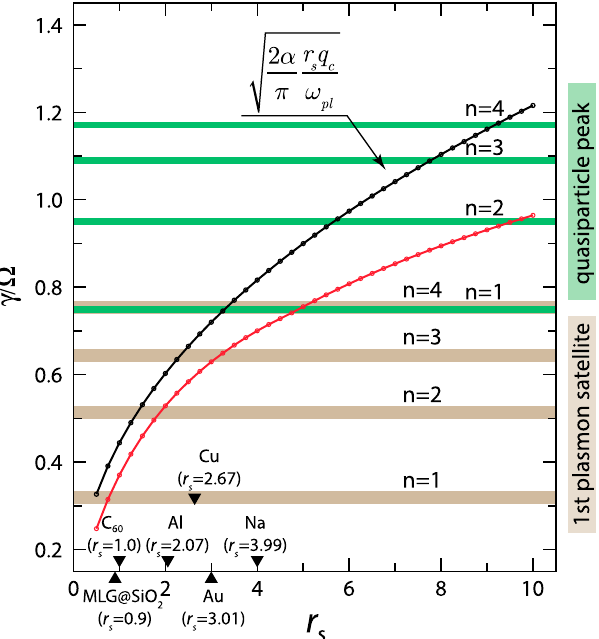
Figure 6. Electron-plasmon coupling as a function of the Wigner-Seitz radius r s . Red curve represents the numerical results obtained by the integration of Eqs (11 and 12), black curve denotes the analytical approximation. On the x -axis materials and their electron densities are additionally depicted. Horizontal lines denote values of a at which positions of main qp -peak and first plasmon satellite are obtained with at least 10% accuracy using the n th-order sc